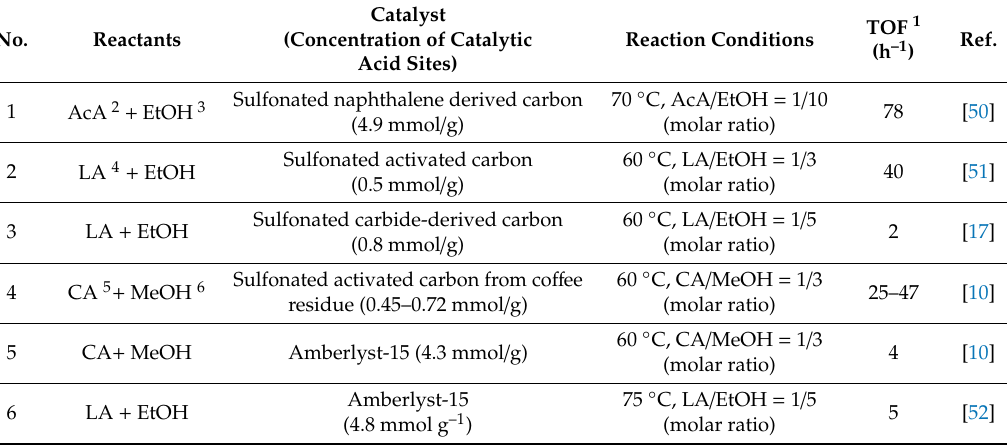
Table 3. Solid acid catalysts in esterification reactions.